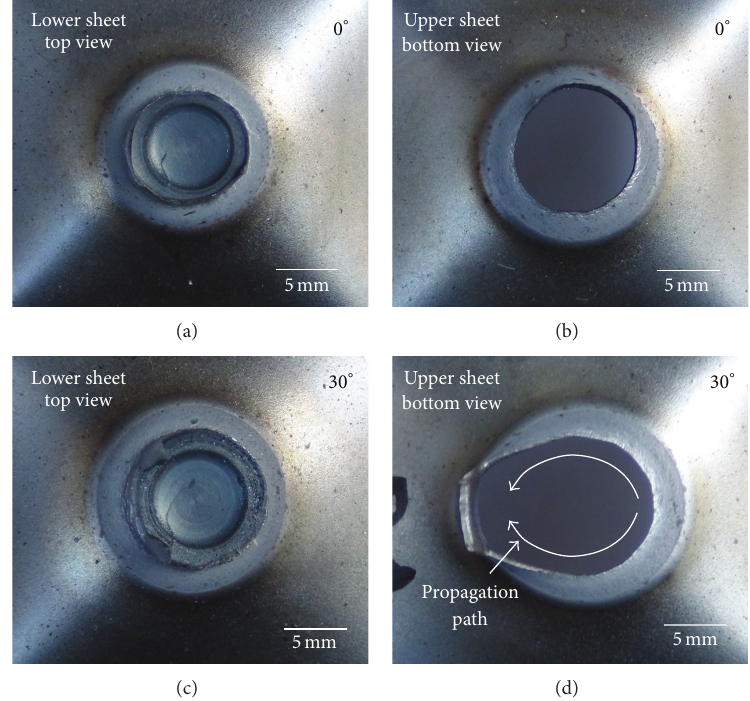
Figure 9: Top and bottom views of the completely separated SPCC/SPCC FSSW joints under ((a), (b)) a pure opening load (𝜙 = 0 ∘ ) and ((c), (d)) a combined load of 𝜙 = 30 ∘ , respectively.